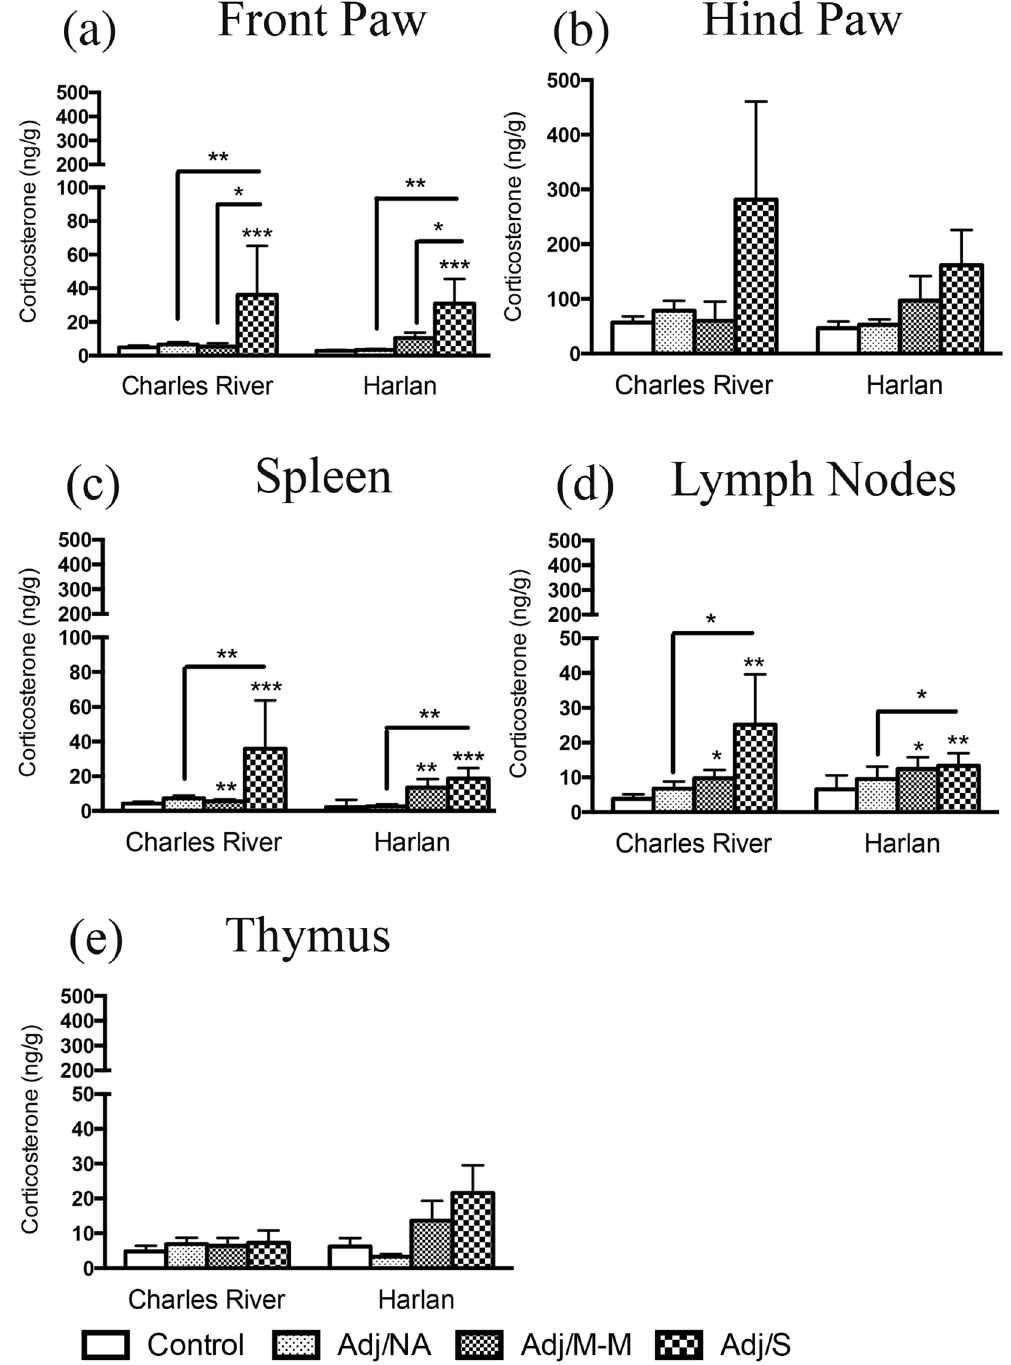
Figure 1. Local corticosterone levels in the paws and immune tissues. Bars represent mean corticosterone level ± SEM. Data are presented as ng corticosterone/g tissue with statistical analysis conducted on Blom transformed (normalized) data. The presence of an asterisk ( * ) indicates a main effect of AA severity, with the comparison to the control group, unless otherwise indicated. Post hoc: * p < 0.05; ** p < 0.01; *** p < 0.001. Control: saline-injected; Adj/NA: no clinical signs of AA following CFA injection; Adj/M-M: mild-moderate AA, clinical score ≥ 1, < 8; Adj/S: severe AA, clinical score ≥